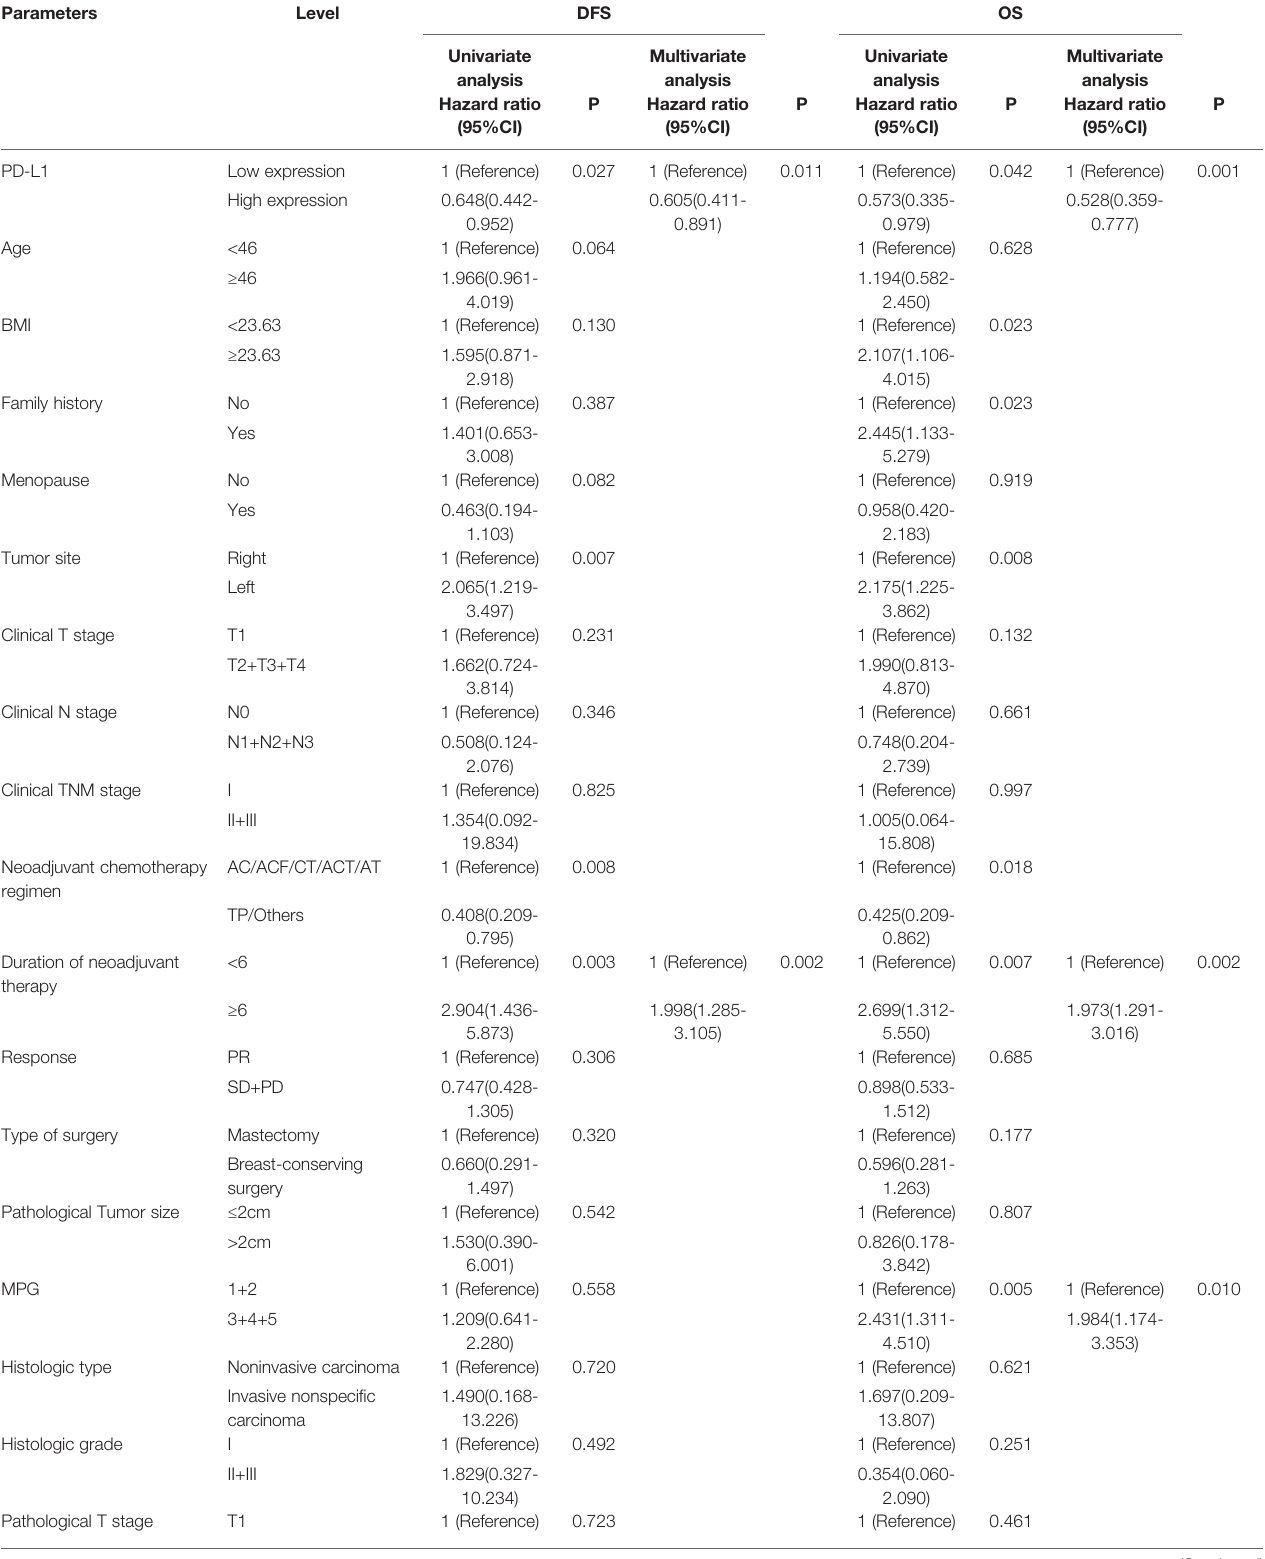
TABLE 5 | Univariate and multivariate Cox proportional hazards regression model for disease free survival (DFS) and overall survival